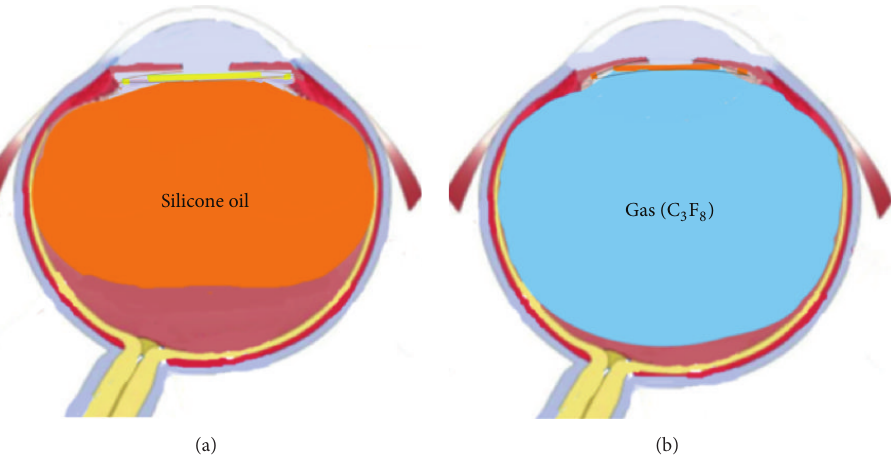
Figure 3: Views of demonstrative image: (a) silicone oil internal tamponade; (b) gas (C 3 F 8 ) internal